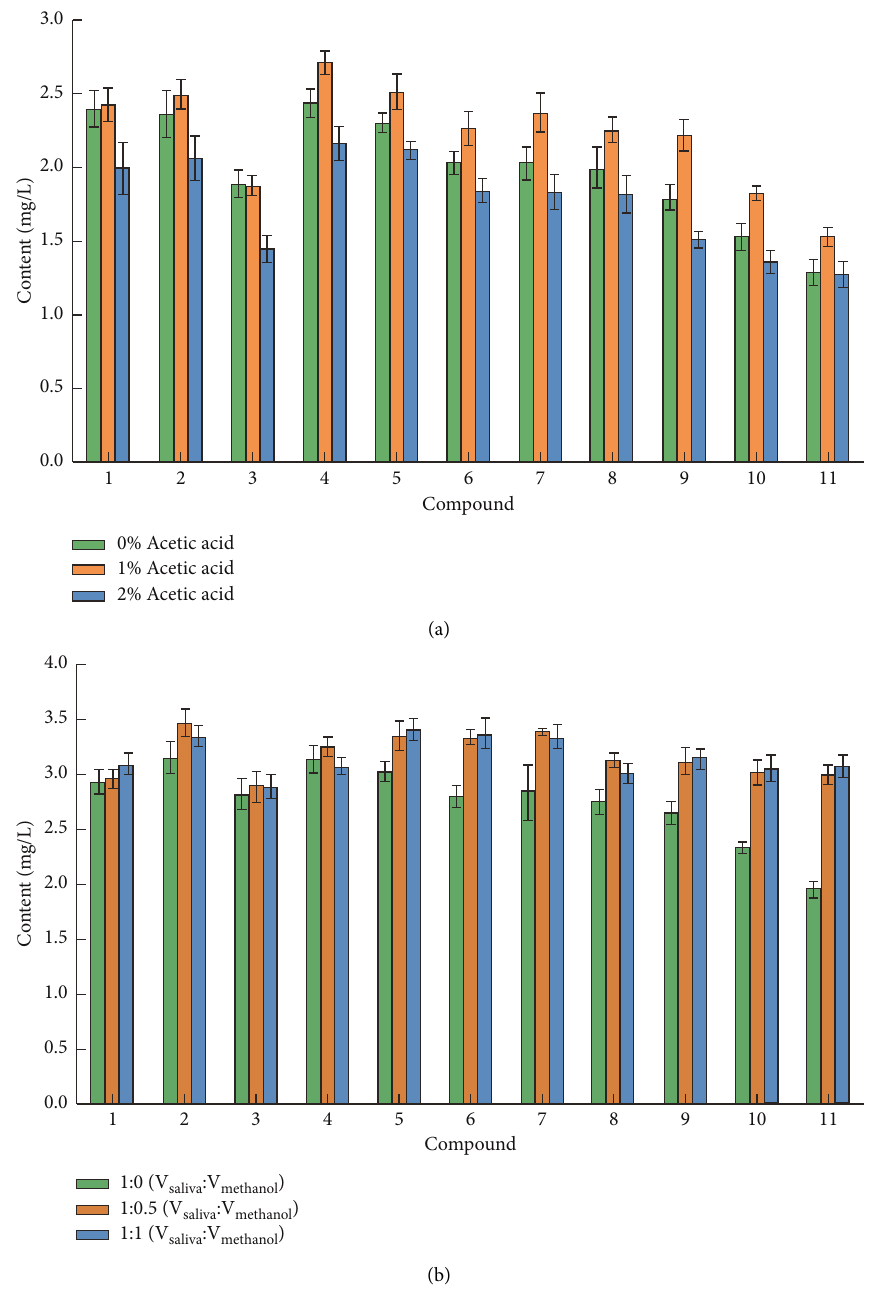
Figure 1: Influence of acidity (a) and proportion of diluent (b) on the determination results for phenolic compounds in saliva samples ( n � 3). The numbers of compounds are the same as in Table